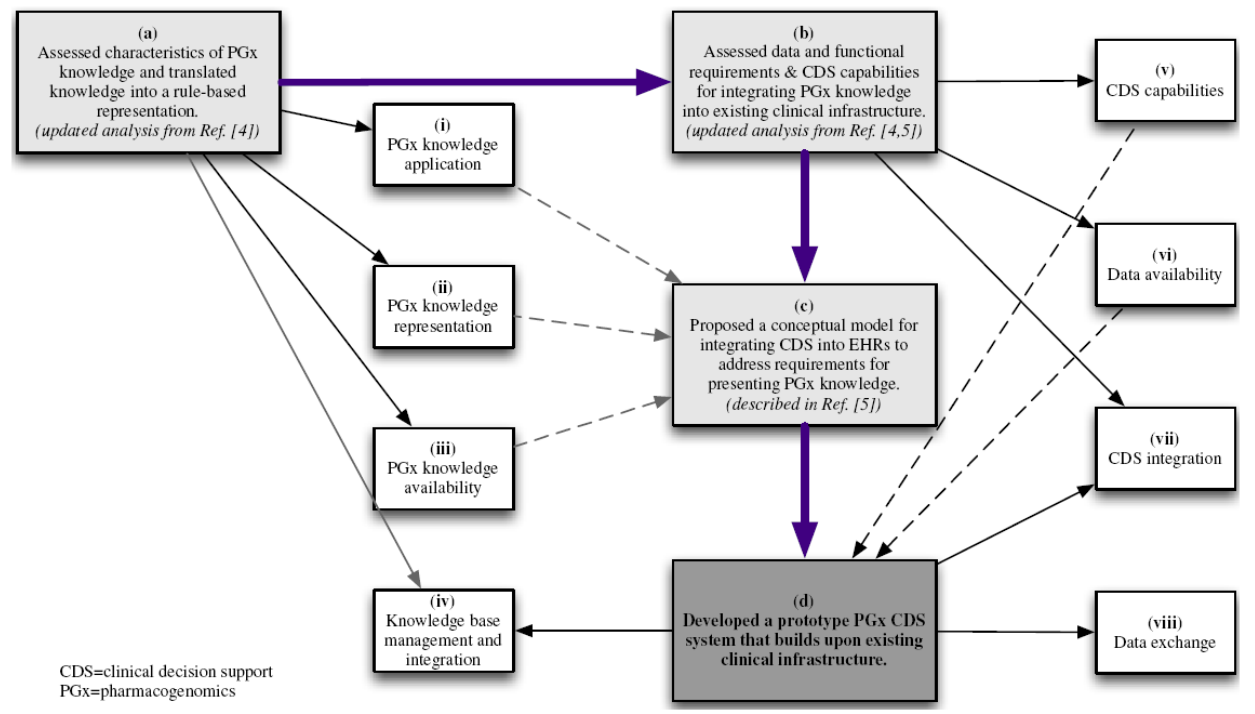
Figure 1. An overview of the rationale behind a prototype pharmacogenomics clinical decision support (CDS) system design. Large boxes indicate methods ( a – d ); solid black arrows point to themes of major findings (small boxes i – viii ); dashed arrows point from themes to methods they inform; bold purple lines illustrate the order methods were performed; relationships indicated by grey lines are not described in this